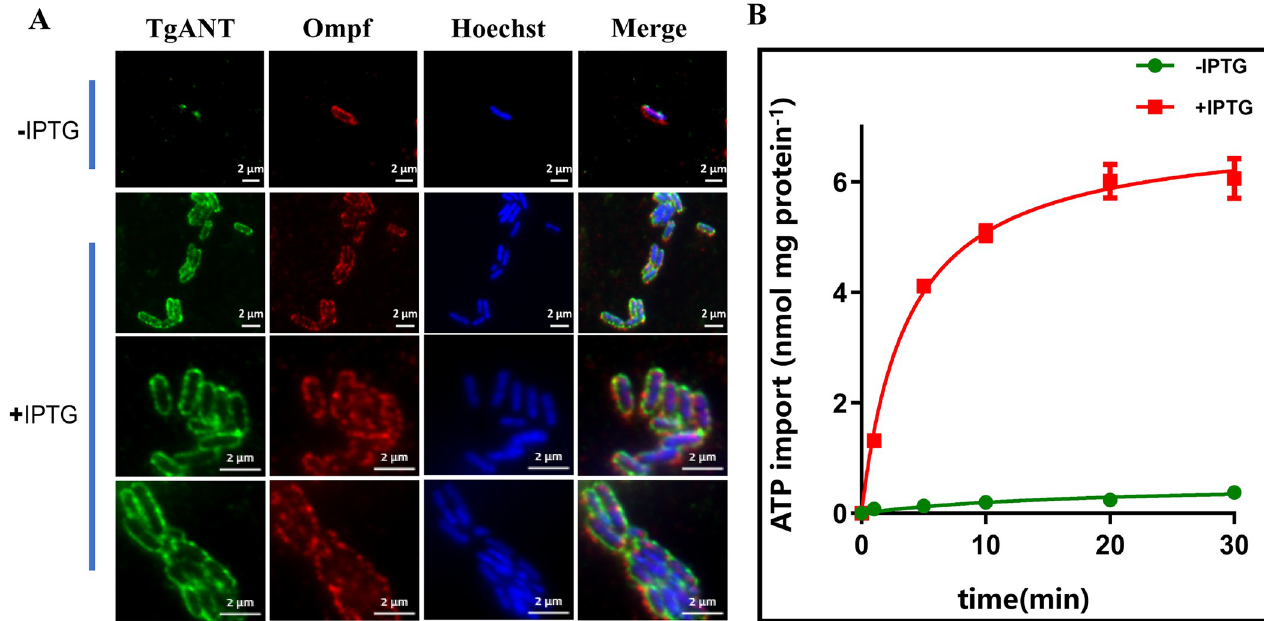
Fig 2. Heterologously expressed TgANT is an ATP and ADP carrier. (A) The E . coil harboring pet16b-TgANT-HA were subjected IFA using antibodies against the HA tag, Ompf (outer membrane porin F) and Hoechst. The result shows that TgANT was expressed in the membrane of E . coil . Scale bars: 2 μ m. (B) Time course for [ α - 32 P] ATP uptake into intact E . coli cells. IPTG-induced E . coli cells harboring the plasmid encoding TgANT were incubated with 25 nM [ α - 32 P] ATP for the indicated time intervals. Noninduced E . coli cells with the plasmid encoding TgANT were used as control. Means ± s.e.m., three independent assays.